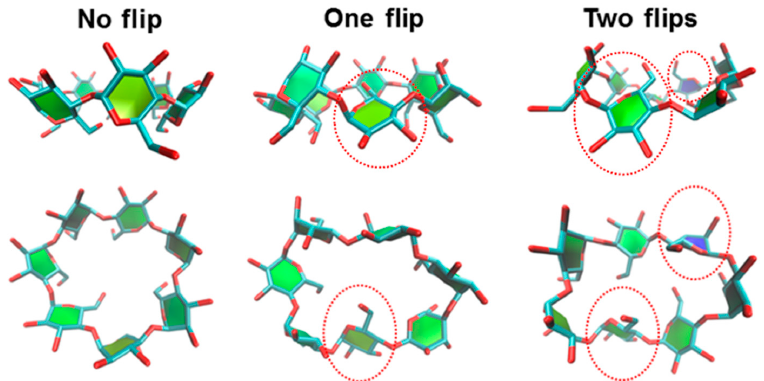
Figure 5. The flipped conformations of β CD with different numbers of flip glucose subunits, which were selected from the simulation at 300 K. were selected from the simulation at 300